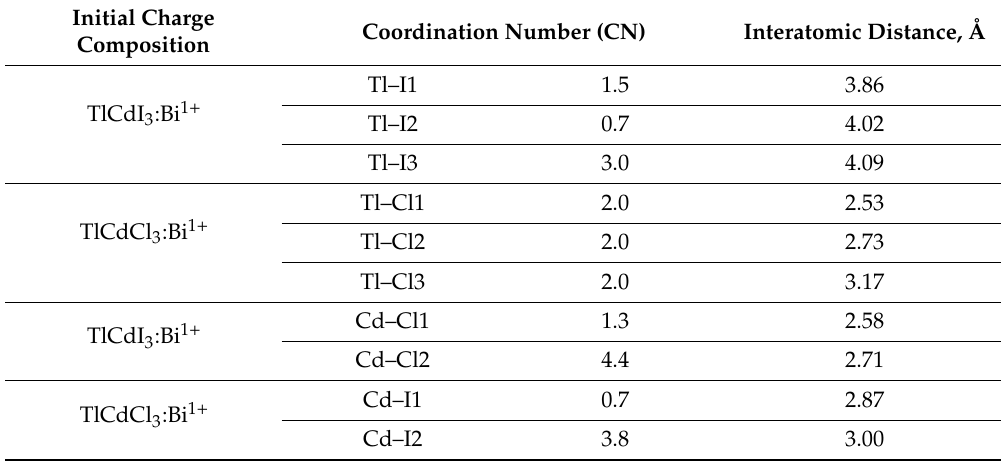
for TlCdCl 3 :Bi and TlCdI 3 :Bi crystals. Table 11. The results of single-sphere EXAFS fit for the TlCdCl 3 :Bi and TlCdI 3 :Bi crystals.